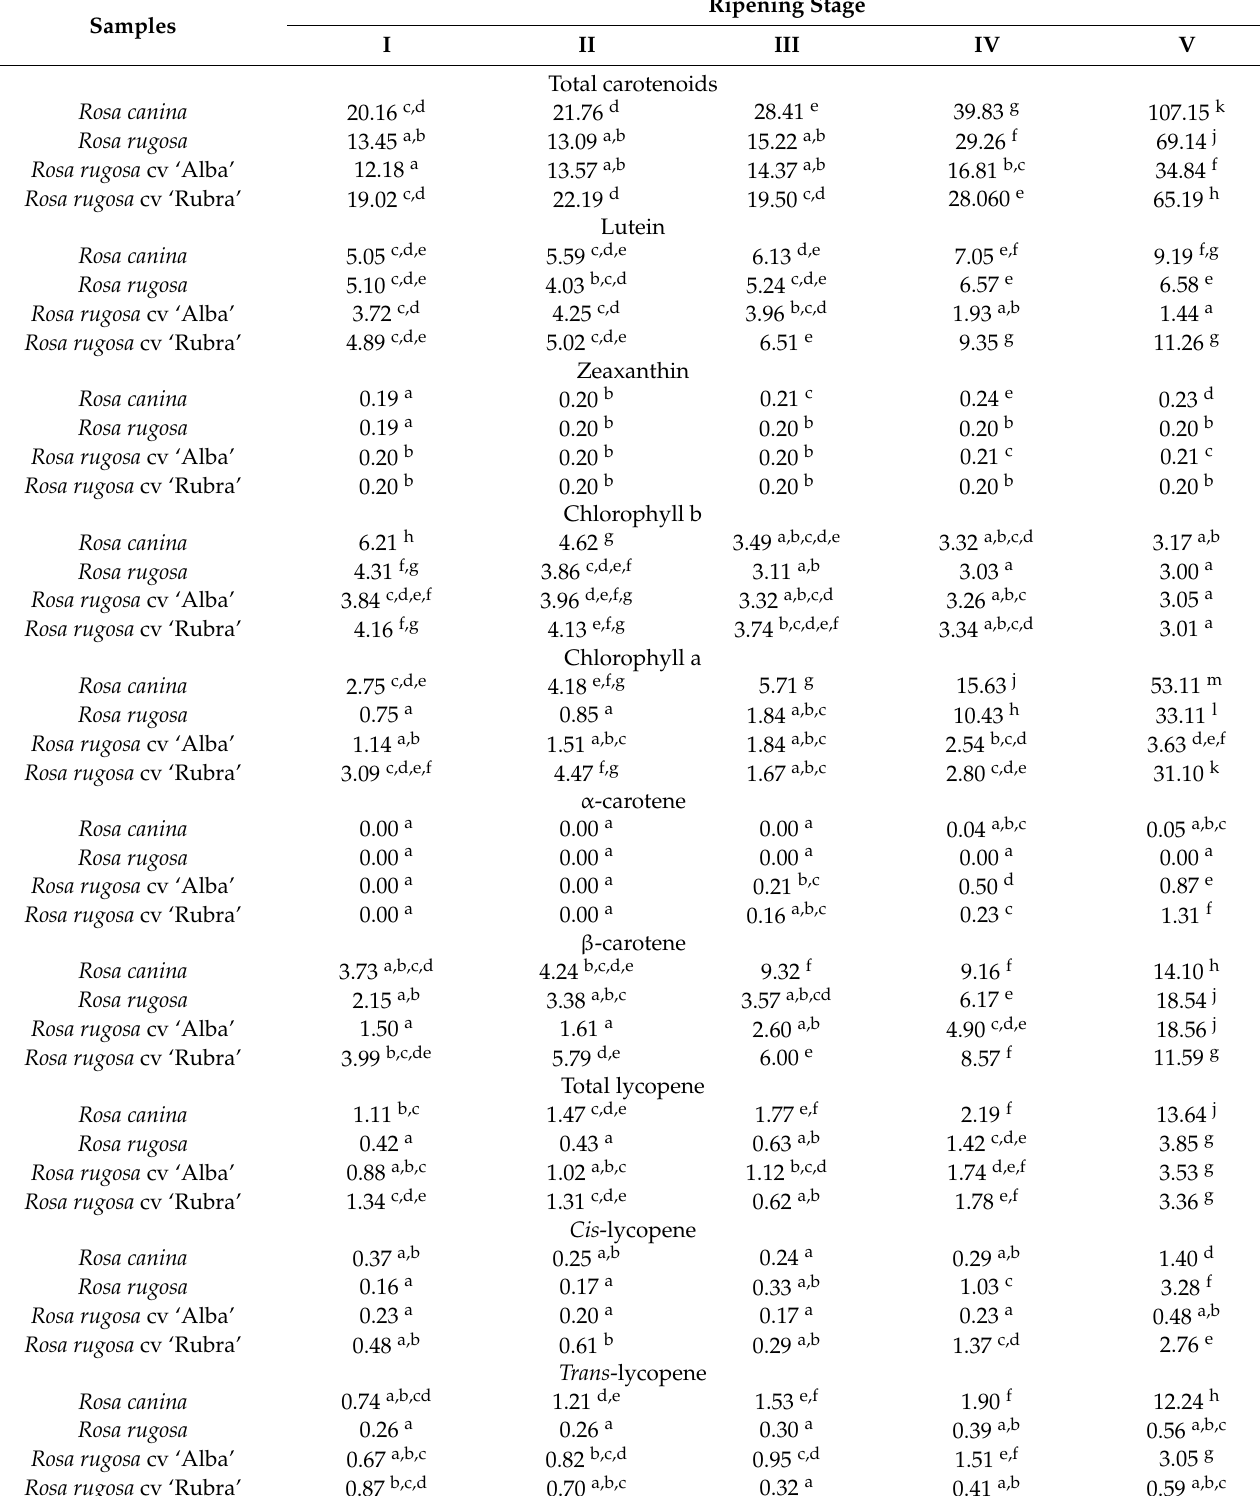
Table 2. Effects of ripening stage on the amounts of carotenoids in the rosehip fruits, mg 100 g − 1 DW.